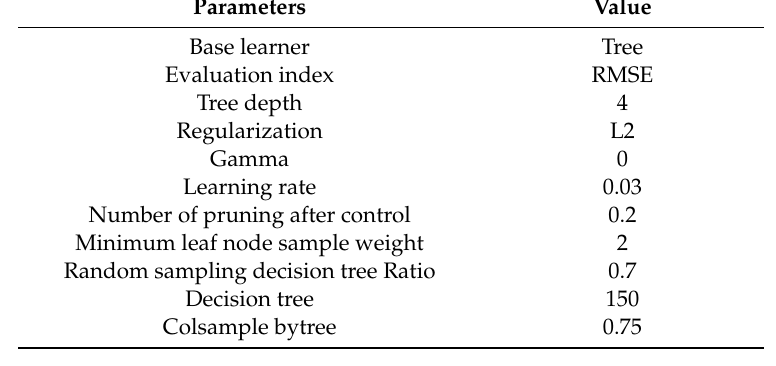
Table 3. Extreme gradient boosting (XGBoost) parameter setting.